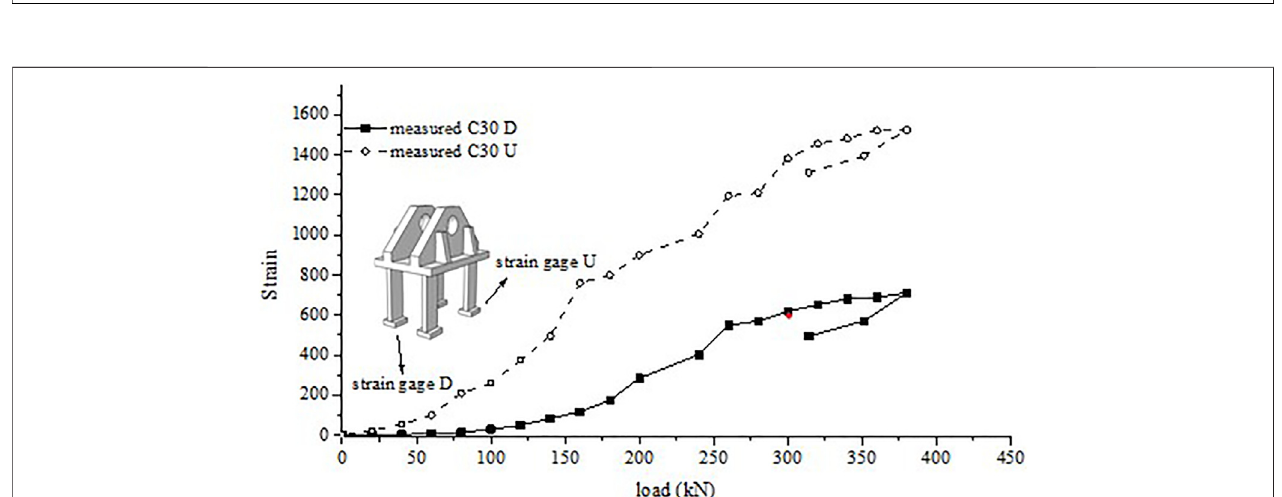
FIGURE 9 | Load – displacement relationships of BFJ.